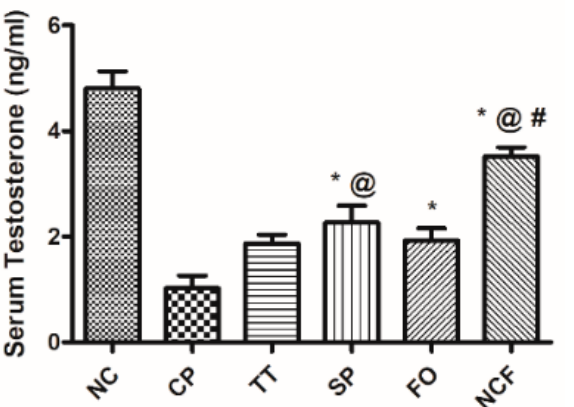
Figure 11. Effect of TT, SP, FO, and NCF on cisplatin-induced alterations in serum testosterone in adult male rats. Effect of 20 days administration of TT (100 mg/kg/orally); SP (1000 mg/kg/orally); FO (400 mg/kg/orally); and new nutraceutical formula (NCF) at a dose of (4.4 g/kg/orally) on serum testosterone. Values are means of 6–10 rats ± SD. Statistical analysis was performed using one-way ANOVA followed by Newman Keuls multiple comparison tests ( p < 0.05). As compared with normal control (NC; *), cisplatin (CP; @), Tribulus terrestris (TT; #). Spirulina platensis (SP), Fish oil (FO).